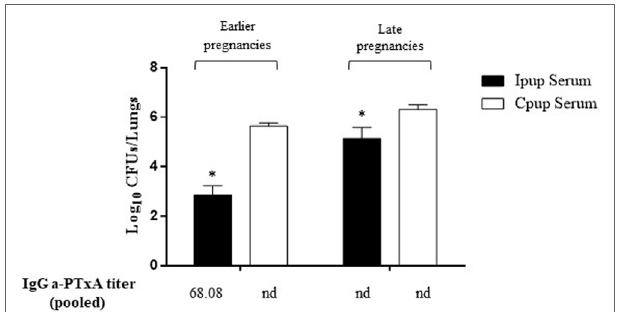
FigUre 3 | Effect of passive immunization on protection through sera collected from Ipups. Pooled sera from either early pregnancy Ipups with high anti-pertussis toxin (a-PTxA) titer or late-pregnancy Ipups with low a-PTxA titer were tested by transfer to naive (Cpup n = 5) female mice. Pooled sera from Cpups transferred to naive female mice were used as negative control of protection. Twenty-four hours after transfer, the mice were infected with Bordetella pertussis and sacrificed 7 days later to determine the CFUs in the lungs. In the figure, the number of bacteria recovered from mouse lungs, expressed as the log 10 of CFUs per lungs, is plotted on the ordinate for each of the two serum-donor groups (early- and late-pregnancies) indicated above the bars. * p < 0.05 Ipup serum versus Cpup serum. The IgG a-PTxA titers are listed for each pool below the abscissa (nd, not